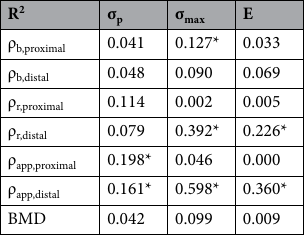
Table 2. R 2 values of regression analysis using power function. All three mechanical parameters can be best explained by distal apparent density. Significant models are marked with